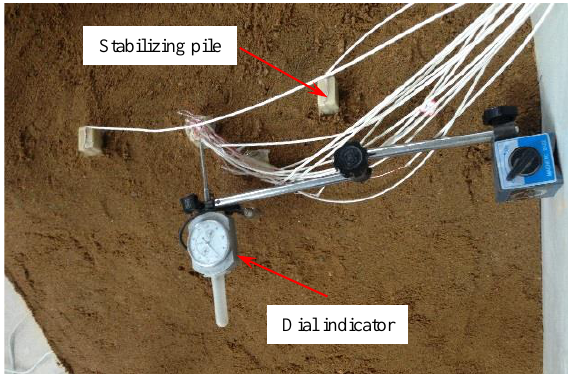
Figure 4. Layout of the stabilizing pile and dial indicator (top view).